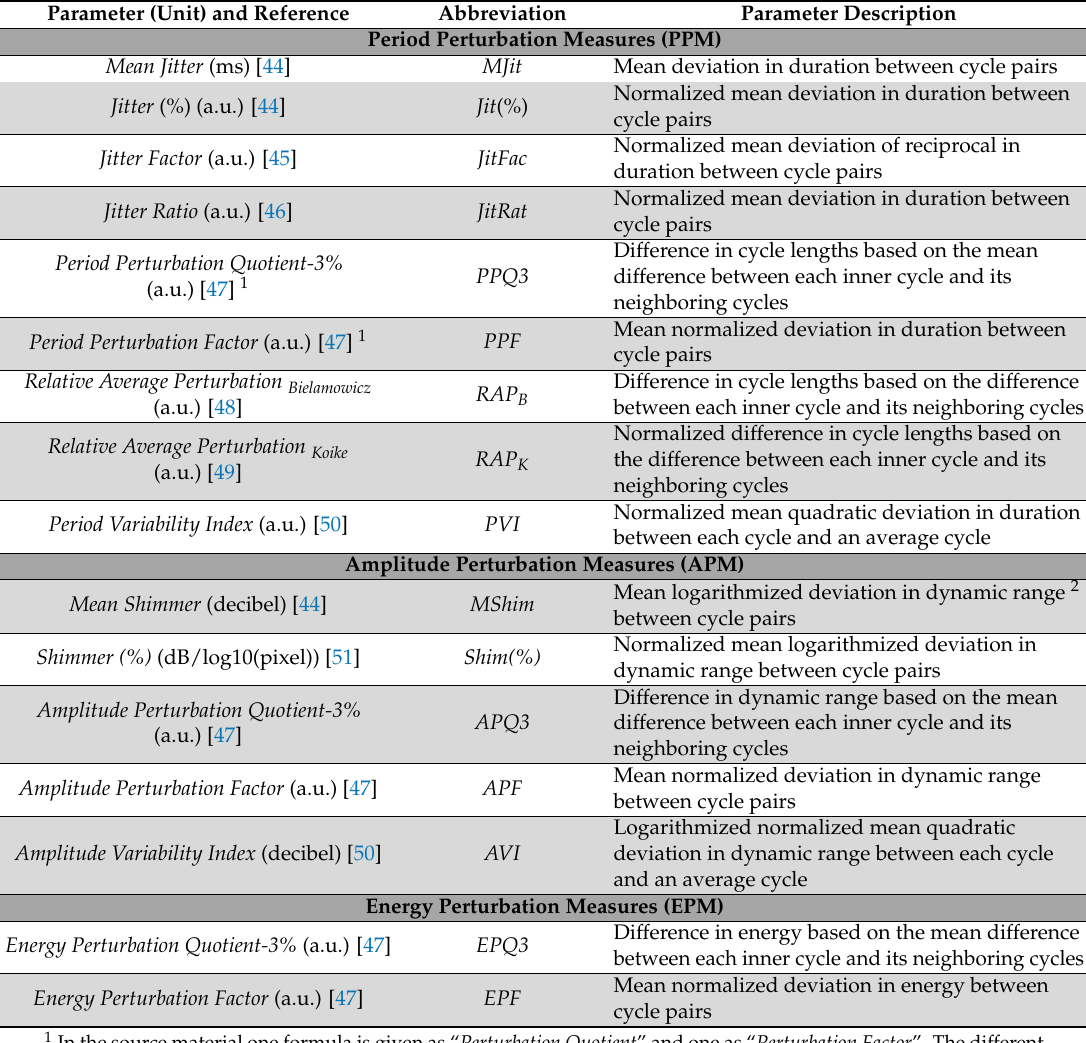
Table 1. Information for all investigated